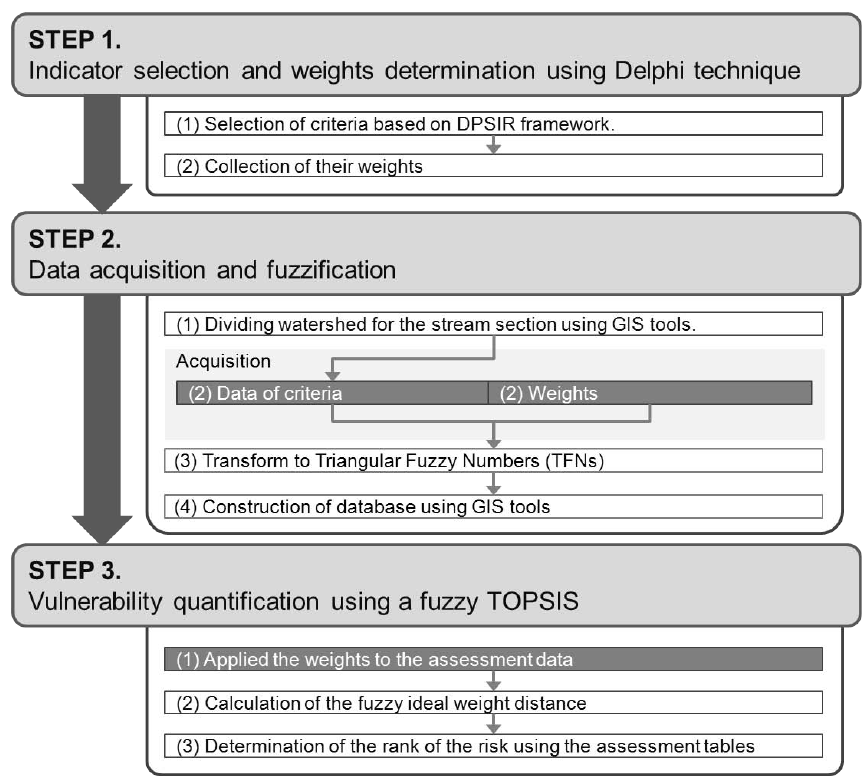
Fig. 1. Procedure of this